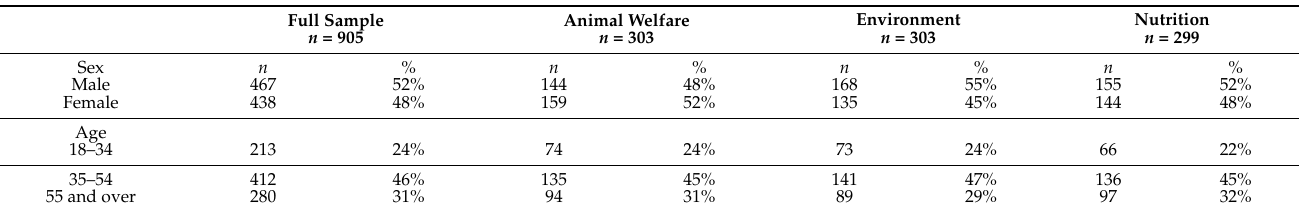
Table 3. Descriptive statistics of the sample and of the treatment